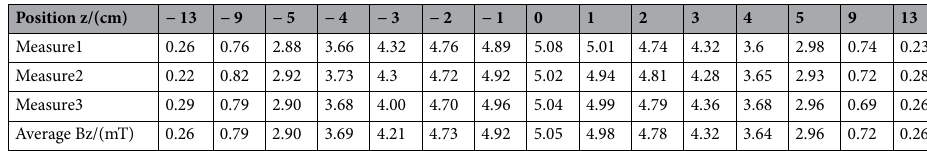
Table 1. Measurement of magnetic field at each position on the